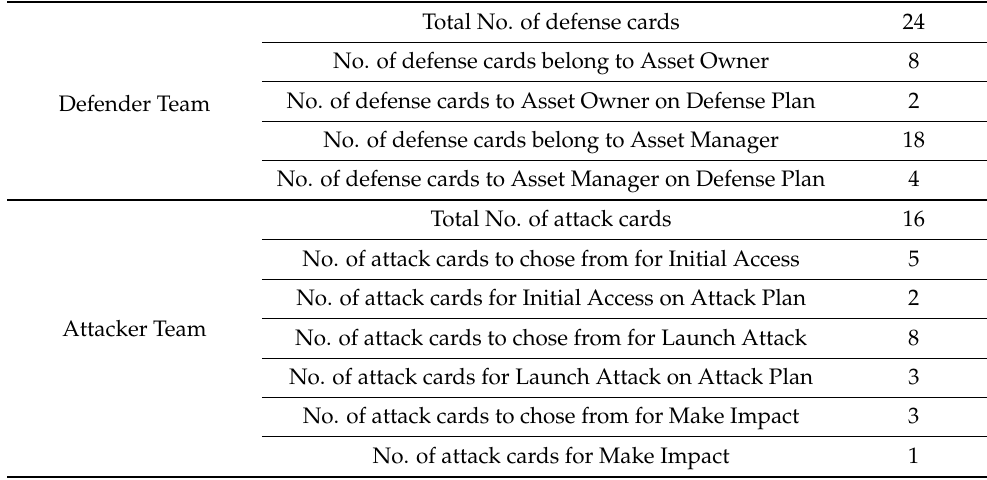
Figure 2. Trial run: a screenshot of the game board on the attacker side. Table 1. No. of cards for defender team and attacker team.